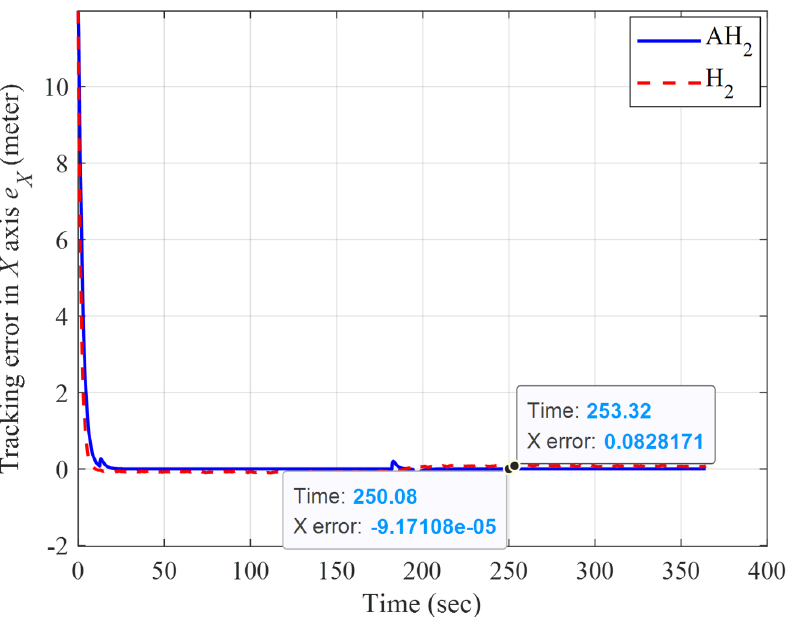
Figure 5. The square trajectory tracking result of the adaptive H 2 closed-form and H 2 closed-form control approaches for the x -axis from x p = 7 m, y p = 7 m.